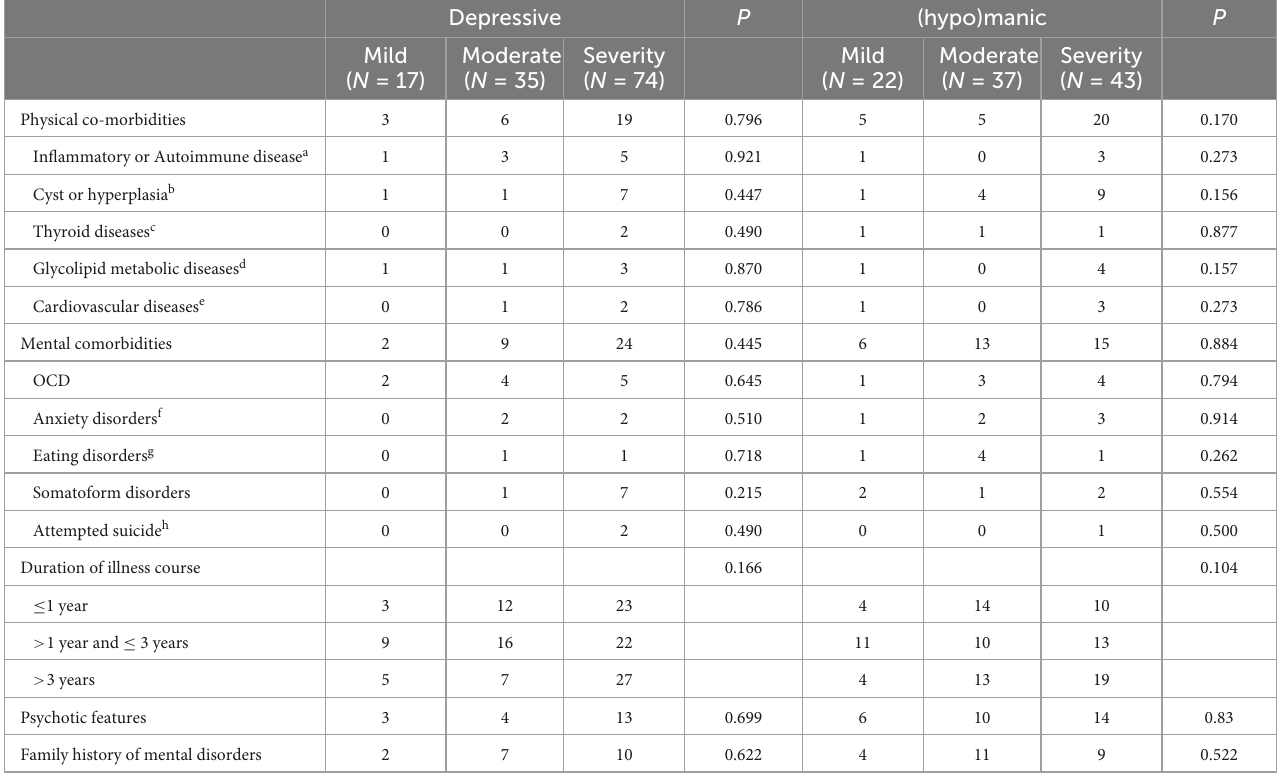
TABLE 3 Comparison of clinical characteristics among BD of different